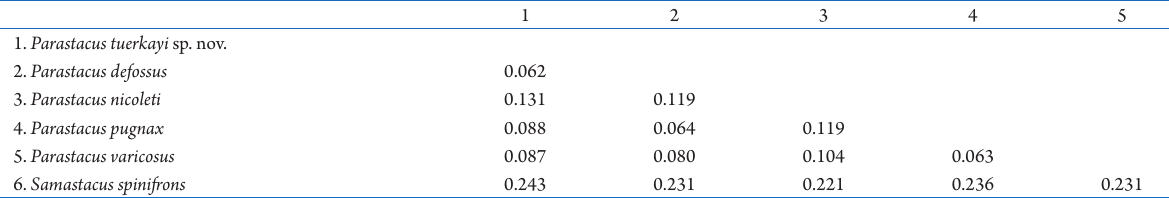
Table 2. Genetic divergence matrix (p-distances) of the 16 S mitochondrial gene among Parastacus tuerkayi sp. nov. and other selected species of the genus Parastacus ( P. defossus , P. nicoleti , P. pugnax and P. varicosus ) and Samastacus spinifrons